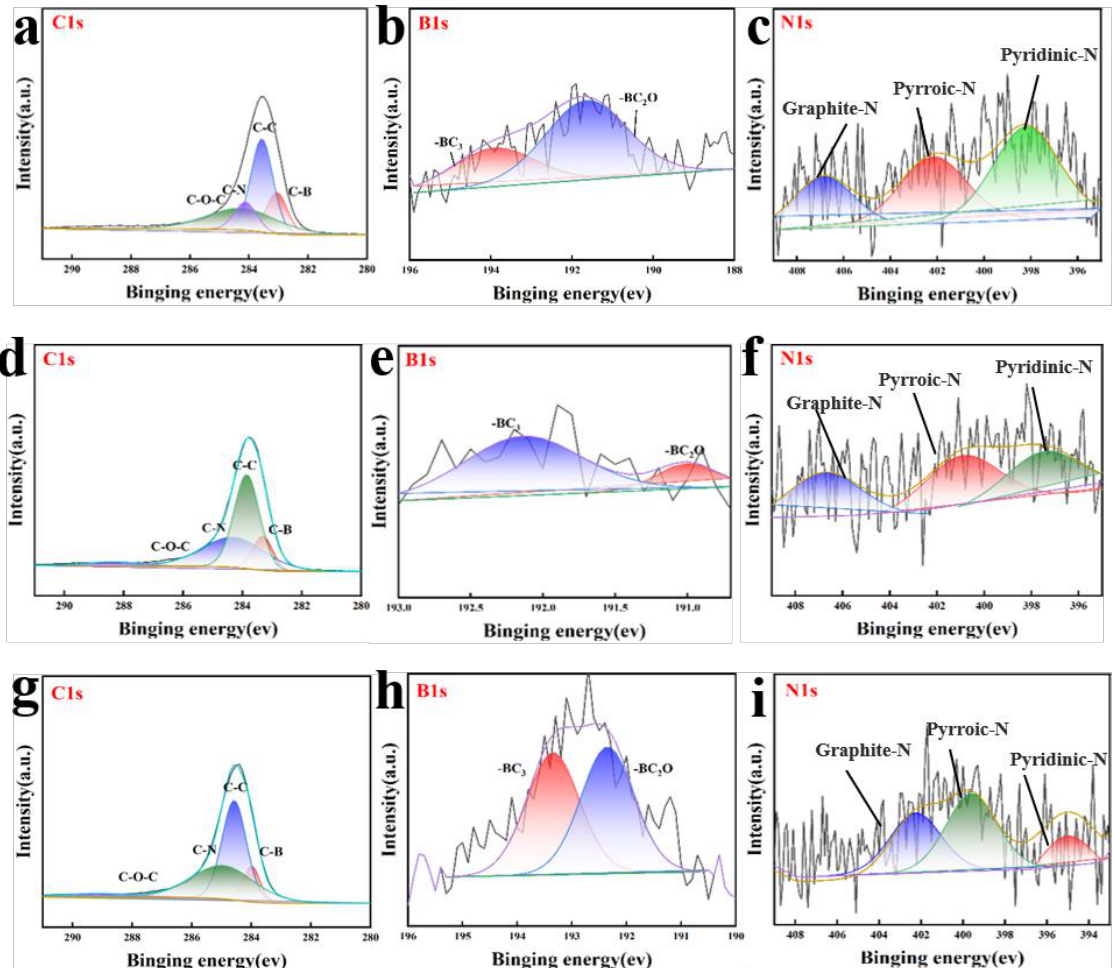
Figure 4. XPS fine spectra of BN/KB materials at different temperatures. ( a – c ) are the fine spectra of C1s, B1s, and O1s at 150 °C. ( d – f ) are the fine spectra of C1s, B1s, and O1s at 175 °C. ( g – i ) are the fine spectra of C1s, B1s, and O1s at 175 °C.